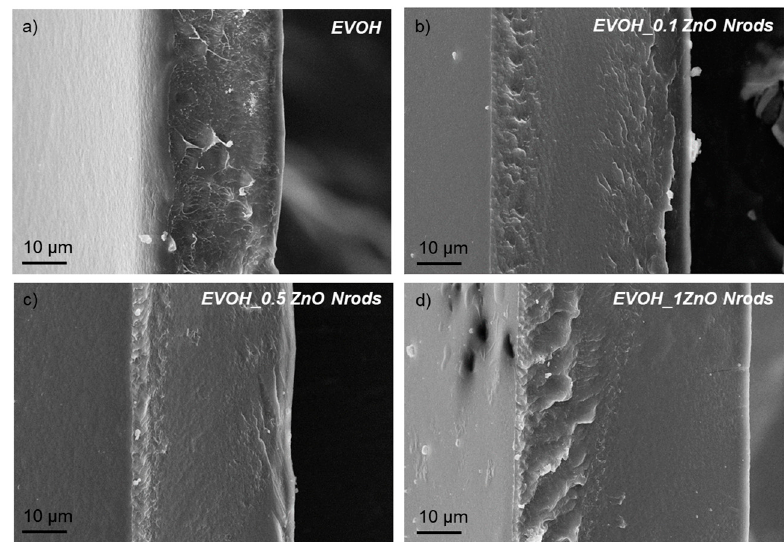
Figure 2. FESEM images of fractured surfaces for EVOH and EVOH_ZnO Nrods-based systems.